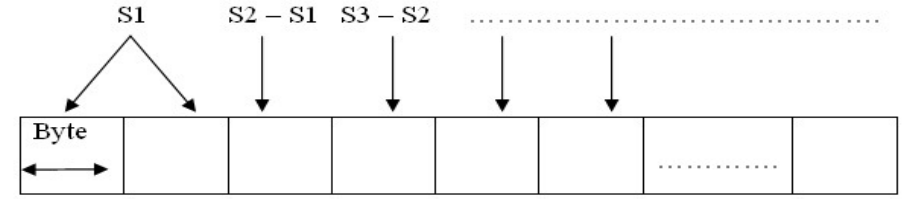
Figure 7. Packaging Data Samples with